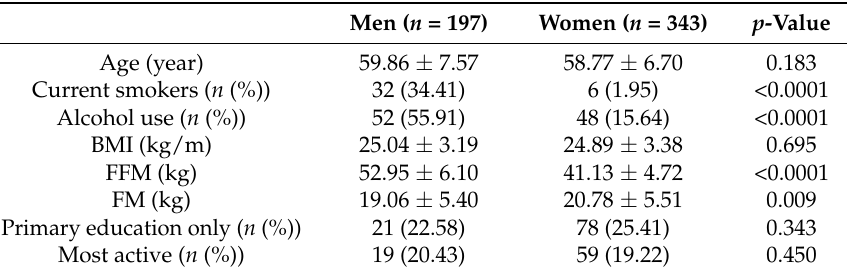
Table 1. Demographic characteristics of the study subjects.